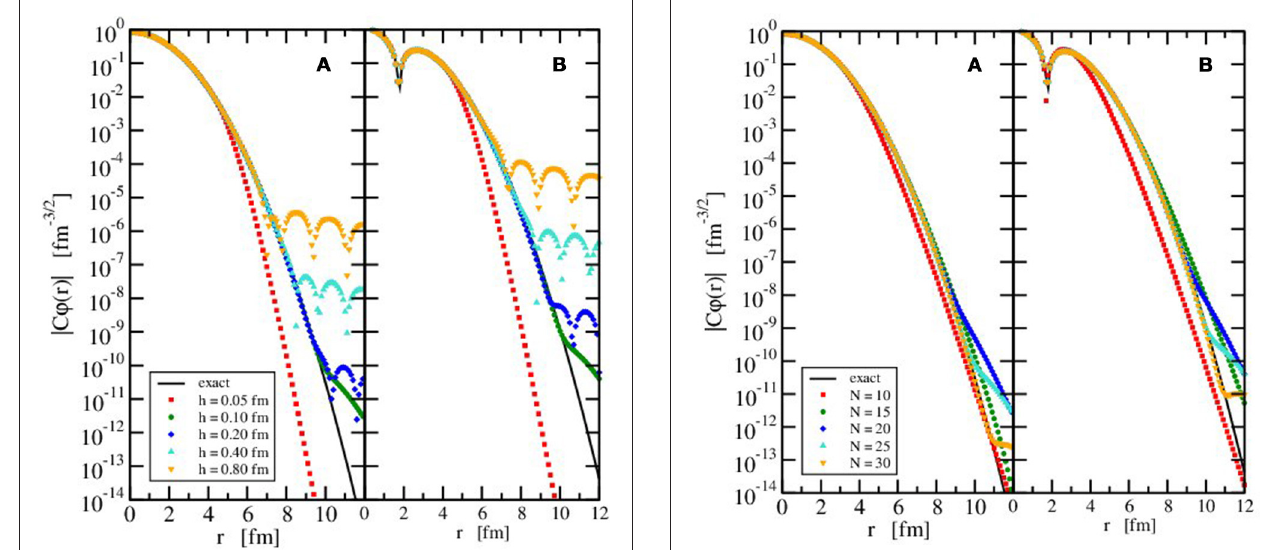
0 in a spherically = h ω 20 MeV and = ¯ 0.10 fm). The normalization factor =